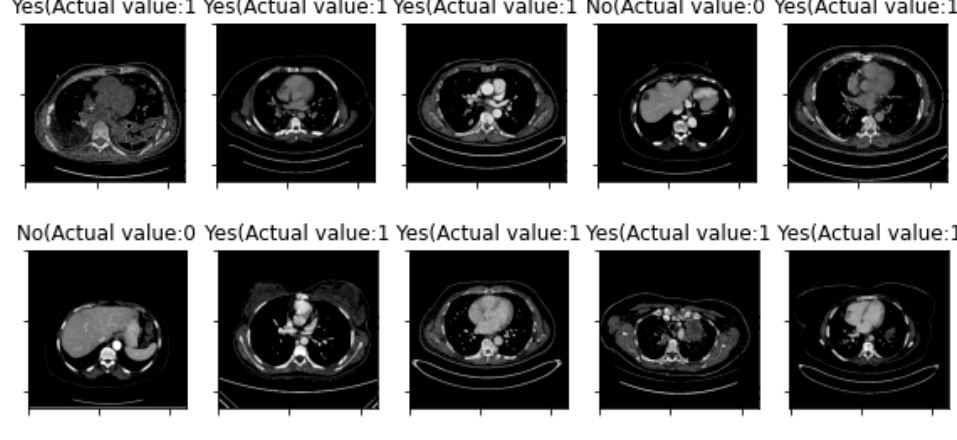
Figure 8. Examples of the classification of CT images containing liver tumors.